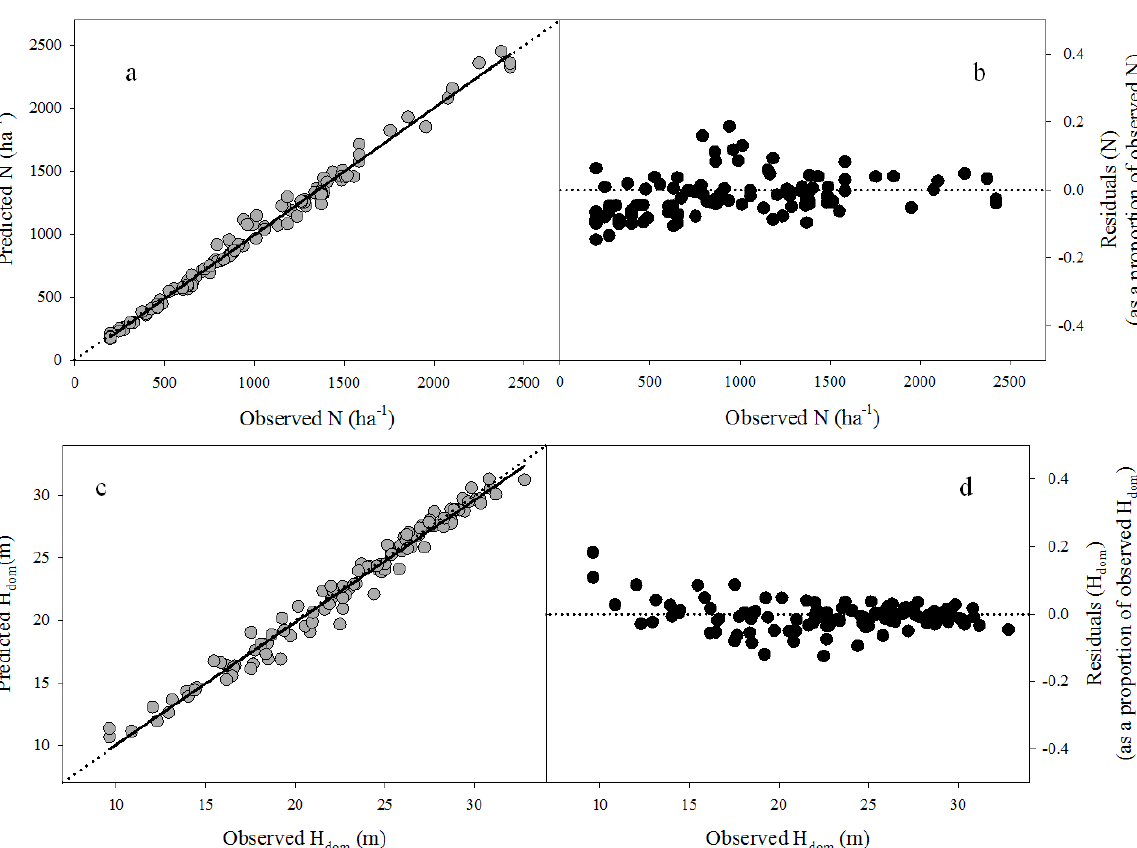
Table 3. The models had a CV of about 11% and an approximate R 2 of 0.99 for both outside and inside bark volume yield breakdown estimates.